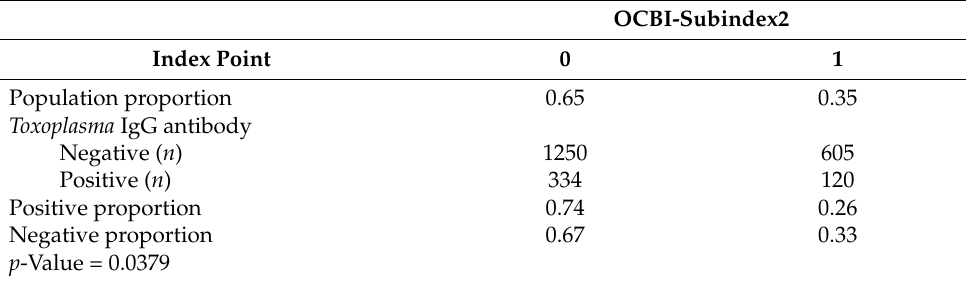
Table 12. Overall index of cardiovascular biomarkers (OCBI-Subindex2).